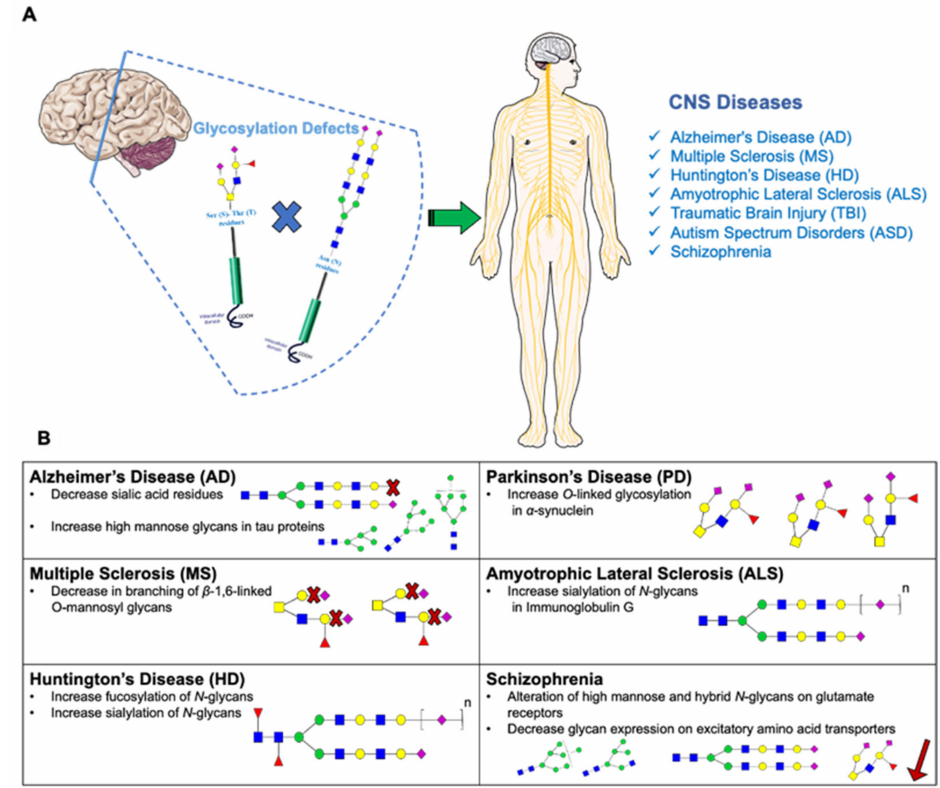
Figure 2. Correlation between glycosylation changes and CNS diseases. ( A ) Depiction of the conse- quences of glycosylation defects occurring in the different lobes of the human brain. ( B ) Characterization of consequences of altered glycosylation based on the type of neurological or psychiatric disease